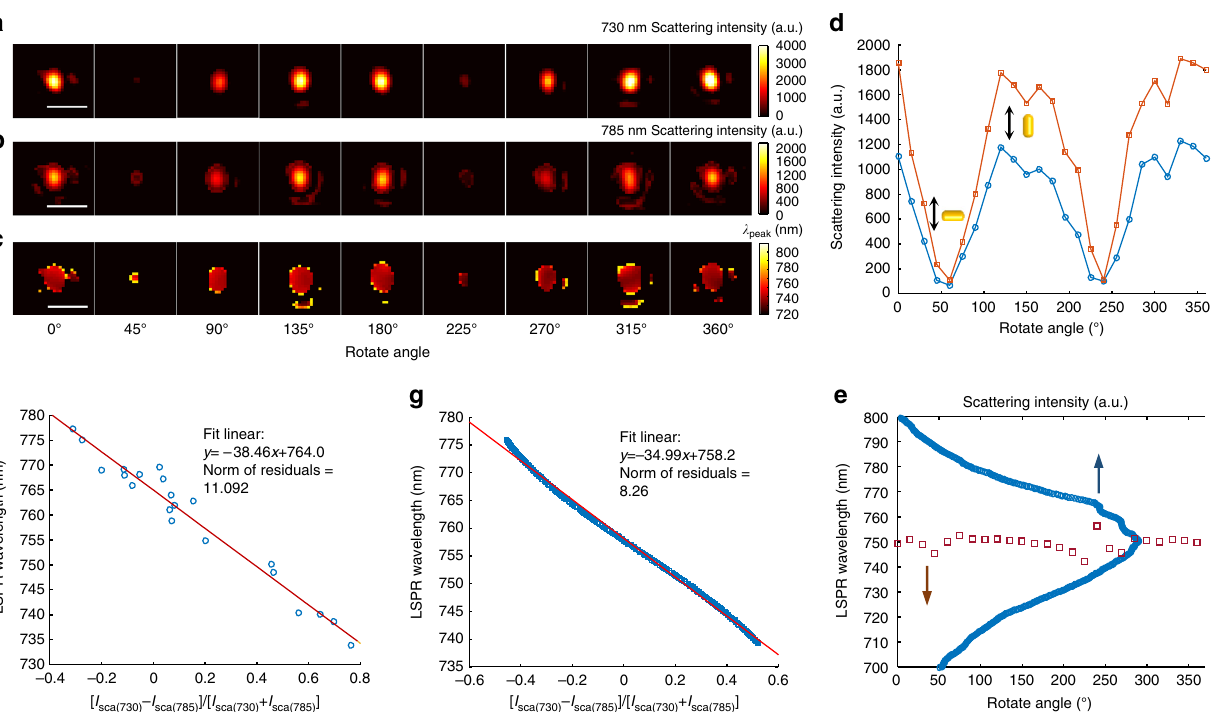
Fig. 3 Accuracy and calibration of the spatiotemporal resolution plasmonic spectroscopy (SRPS). a − c 730 nm channel a , 785 nm channel b dark- fi eld snapshots and converted LSPR wavelength images c of a single gold nanorod which rotated from 0 to 360 º . Scale bar is 1 μ m. d Rotation angle-dependent scattering intensity of 730-nm (squares) and 785-nm (circles) channel snapshots. e Rotation angle-dependent LSPR wavelength (squares) and scattering spectra obtained by a commercial spectrograph (circles) of the same gold nanorod. f A calibration curve illustrating the linear relationship between values (cid:1) (cid:3) of I sca 730 ð Þ (cid:2) I sca 785 ð Þ = (cid:3) ½ I sca 730 ð Þ þ I sca 785 ð Þ and scattering spectral peak wavelengths of single gold nanorods. g A calibration curve illustrating the linear relationship between simulated values of I sca 730 ð Þ (cid:2) I sca 785 ð Þ = (cid:3) ½ I sca 730 ð Þ þ I sca 785 ð Þ